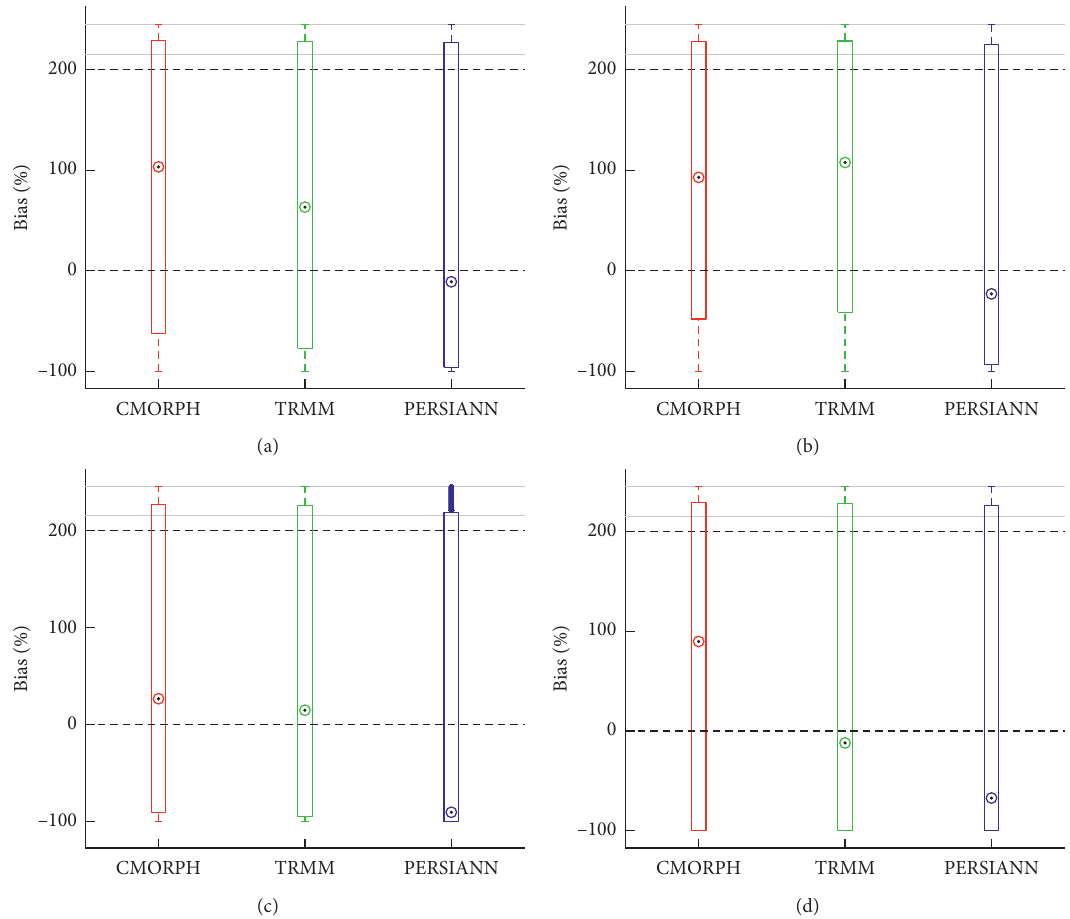
Figure 5: The bias distribution of each satellite dataset over the Three Gorges Reservoir area in (a) spring, (b) summer, (c) autumn, and (d) winter. The upper and lower boundary of each box represented the 25 th and 75 th percentiles of the samples, the circle with a black dot inside denoted the median in each bar, and the bias rate was confined within 300% for